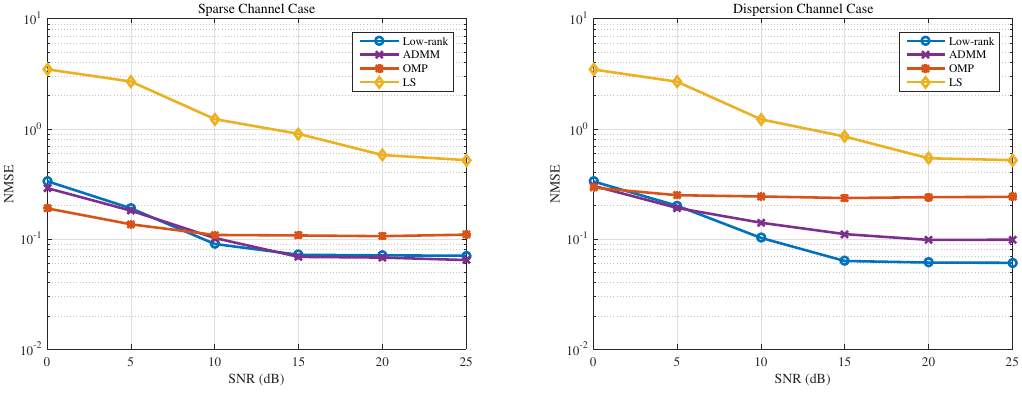
Figure 5. NMSE comparison versus SNR.